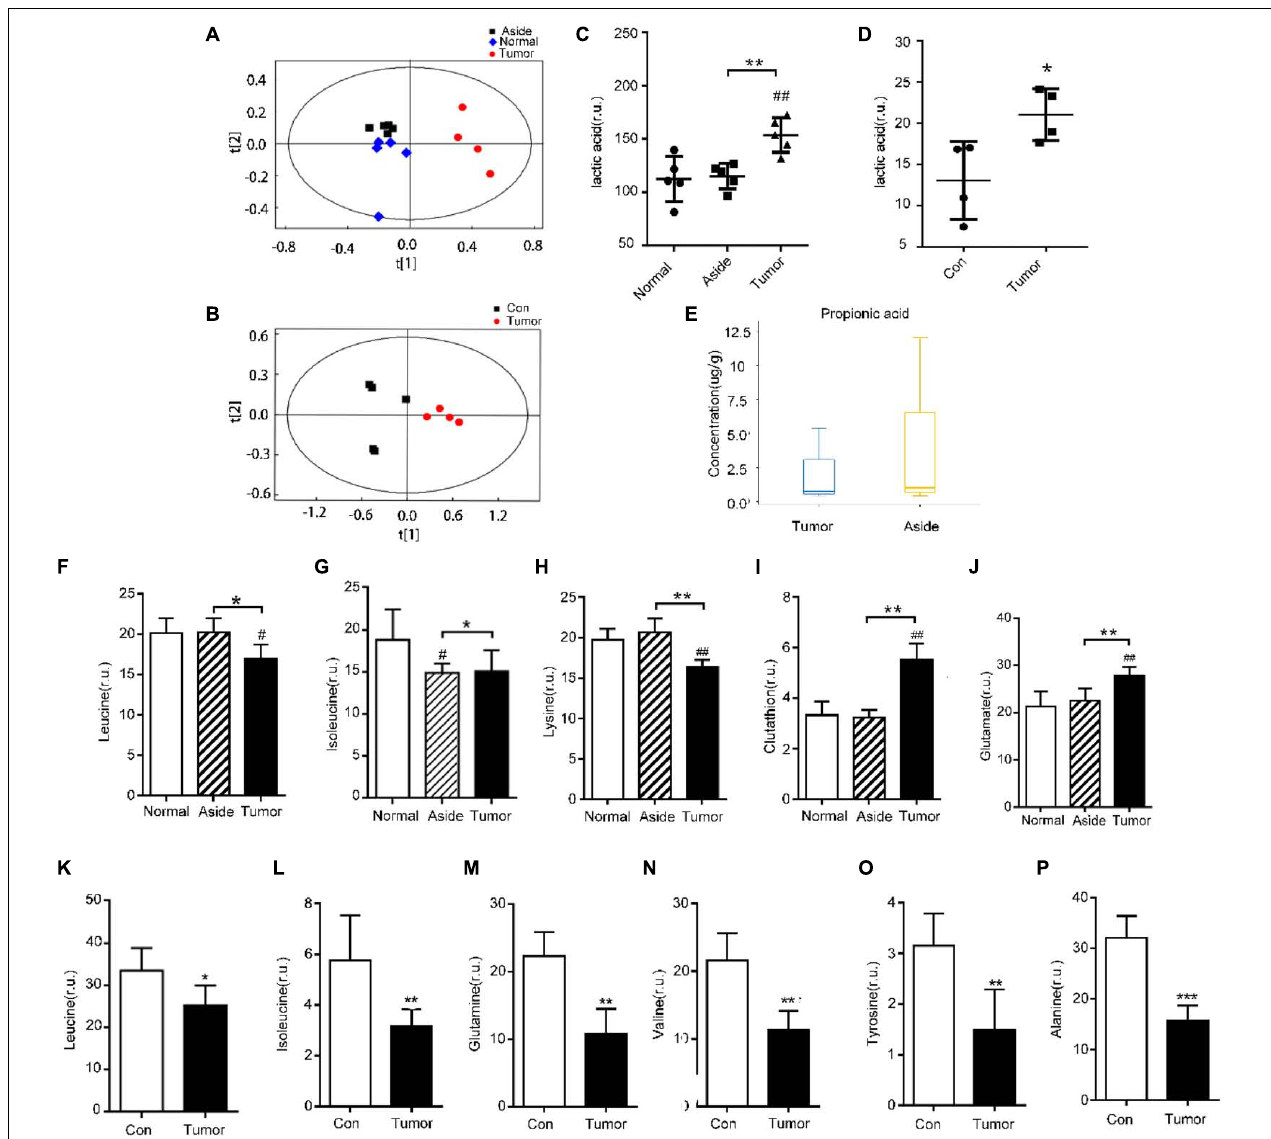
FIGURE 4 | Detection of metabolites in the tissues and serum of CRC patients and healthy people. (A,B) Principal component analysis (PCA) of metabolites in tissues and serum of CRC patients, respectively; (C,D) detection of lactic acid in tissues and serum of CRC patients, respectively; (E) propionic acid in tissues of CRC patients; (F–J) differential metabolites in various tissues of CRC patients with NMR, # P < 0.05, ## P < 0.01, * P < 0.05, ** P < 0.01; and (K–P) differential metabolites in serum of CRC patients and healthy individuals, * P < 0.05, ** P < 0.01, *** P <